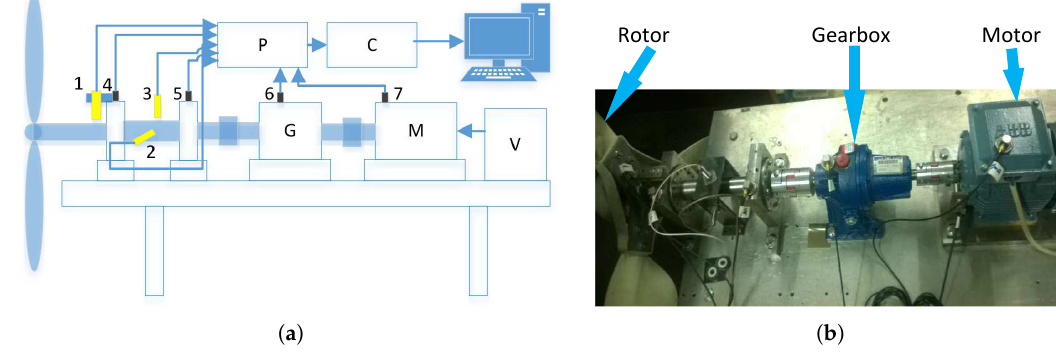
Figure 10. Structure of the test rig: ( a ) structure diagram, where G is the gearbox, M is the motor, V is the variable frequency drive, P is the signal pre-processors, C is the collector, 1 to 7 are sensors, 1 is the rotational speed sensor and 6 is the gearbox vertical acceleration sensor; ( b ) picture of the test rig.